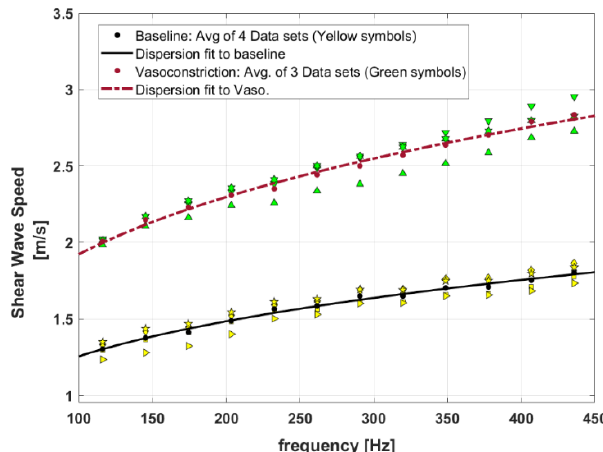
Figure 7. Shear wave speed dispersion curves for the baseline perfused placenta versus placenta in vasoconstriction. Yellow symbols show four different datasets from baseline measurements and green symbols present three different datasets from vasoconstriction measurements. The fitted curves are results of power-law fitting to the average of measured datasets for each condition (baseline and vasoconstriction).